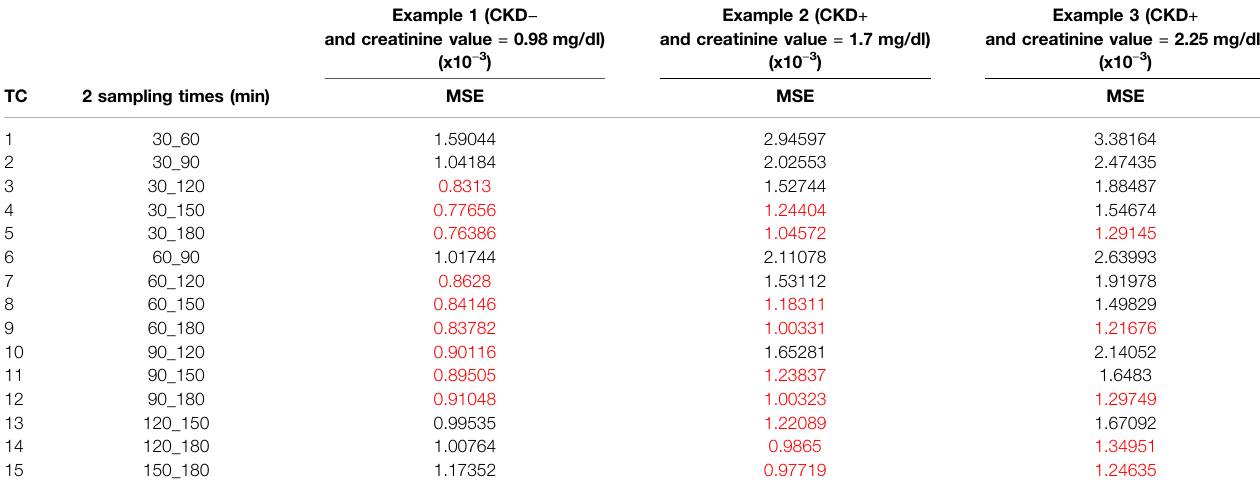
TABLE 4 | Mean square error for the time combination K (MSE K ) results of optimal designs including 2 samples (TC: times combination). The best sampling times for each example of dogs are in red. Example 1 (CKD − and creatinine value = 0.98